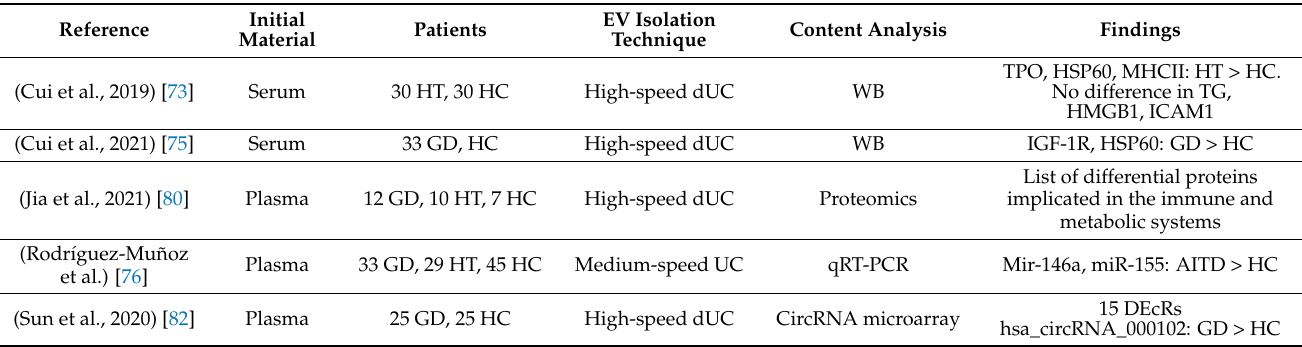
Table 4. List of publications questioning the diagnostic value of EVs in AITDs. HC—Healthy Controls; HT—Hashimoto’s Thyroiditis; GD—Graves’ Disease; (d) UC—(differential) UltraCentrifu- gation; WB—Western Blot; qRT-PCR—quantitative Real-Time Polymerase Chain Reaction; DEcRs— Differentially Expressed